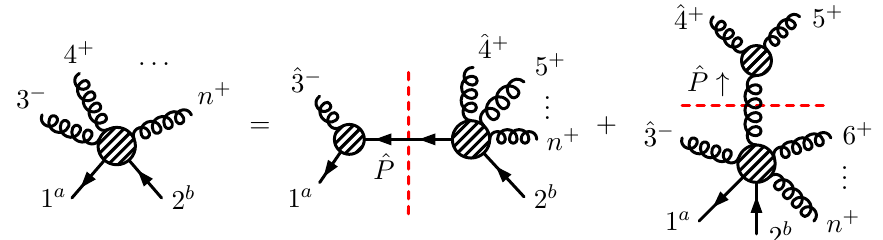
Figure 3 . Graphic representation of the BCFW recursion step (4.9) for A (1 a ; 3 (cid:0) ; 4 + ; : : : ; n + ; 2 b